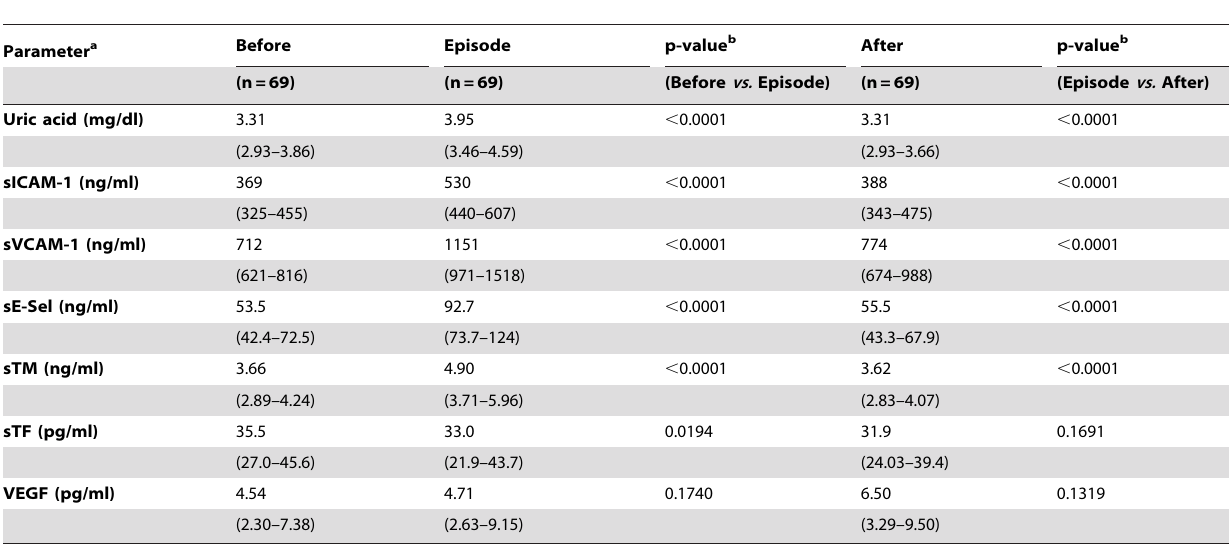
Table 2. Plasma levels of UA and biomarkers of endothelial activation/damage before, during and after an episode of P. falciparum